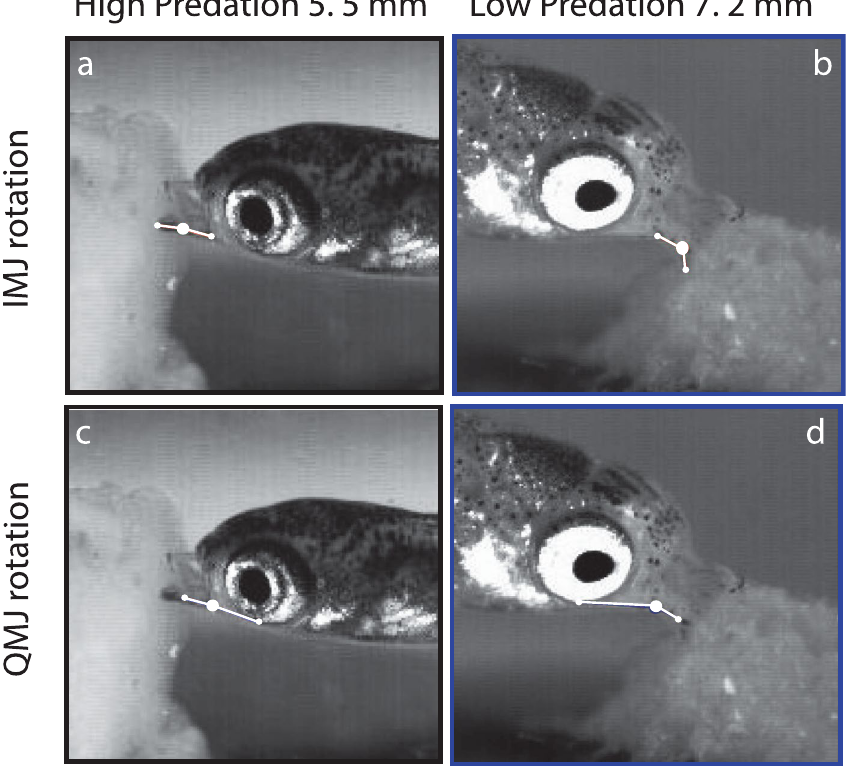
Figure 3. Feeding kinematics in neonates from HP and LP populations. Standard length of the two individuals is shown at top. ( a , b ) Intramandibular (IMJ) rotation angle between high-predation ( a ) and low-predation ( b ) neonates. ( c , d ) Quadratomandibular (QMJ) rotation between high ( c ) and low ( d ) predation neonates. Rotation at the IMJ, but not at the QMJ, increases with neonatal size.